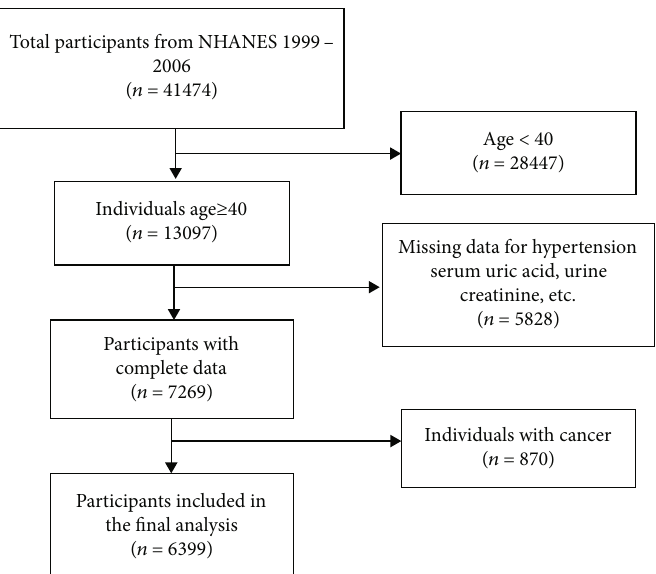
Figure 1: Sample screening fl ow